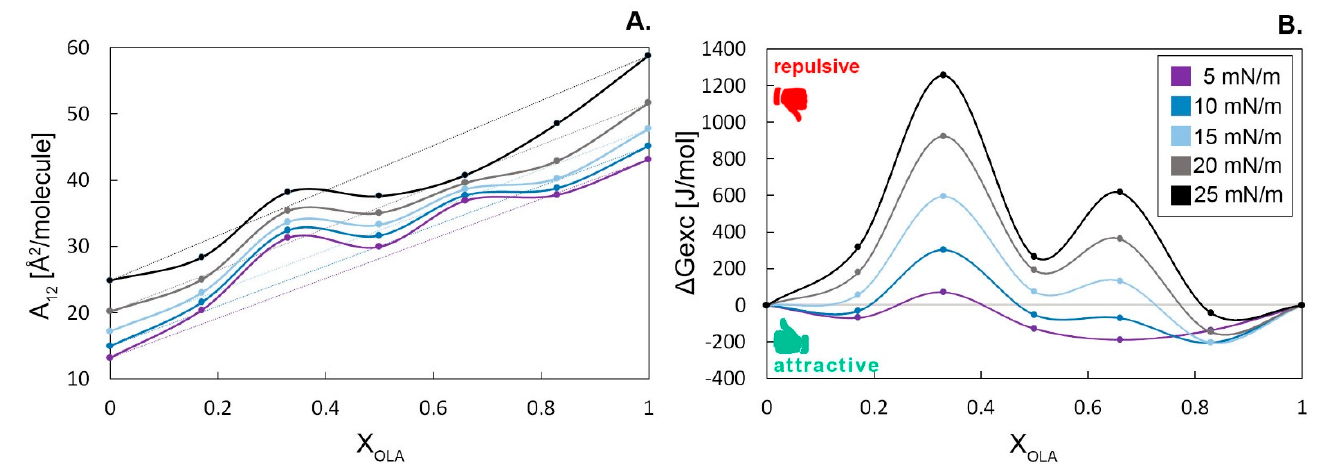
Figure 3. ( A ) The plot of mean area per molecule (A 12 ) vs. composition (X OLA ) for OLA:OA mixed monolayers and ( B ) the excess free energy of mixing ( ∆ G exc ) vs. composition (X OLA ) for OLA:OA mixed monolayers; both are at constant surface pressures ranging from 5 to 25 mN/m. The gray lines in figure A represent the behavior of the ideal binary system. Due to the positive values of ∆ G exc at B, the system of OLA:OA 1:5 seems to be immiscible with repulsive interactions between components, in contrast to the OLA:OA 5:1 system, where components are miscible in a whole range of surface pressures investigated.